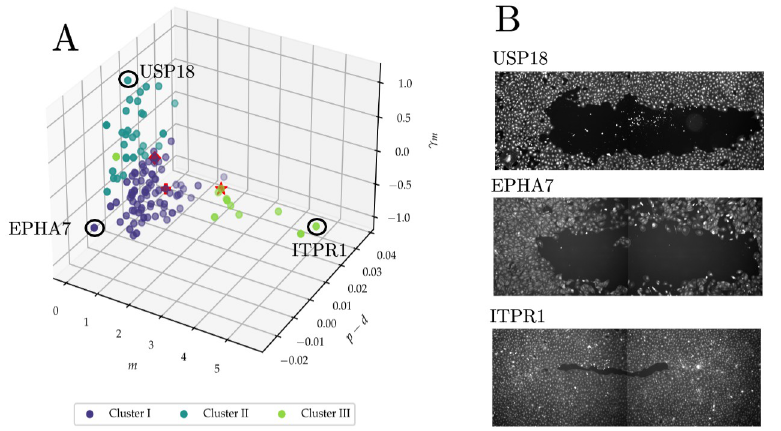
Fig 7. Identifying functional subgroups among perturbations. A: Three-dimensional scatter plot of the posterior means for the intrinsic motility parameter, m , intrinsic net proliferation parameter, p − d , and density-dependent motility parameter, γ , for each of the samples in the high-throughput screen. Star denotes Mock, diamond denotes m CDC42 knockdown and plus denotes CDH5 knockdown. B, top to bottom: wound mask for one final condition of the USP18, EPHA7, and ITPR1 knockdowns,